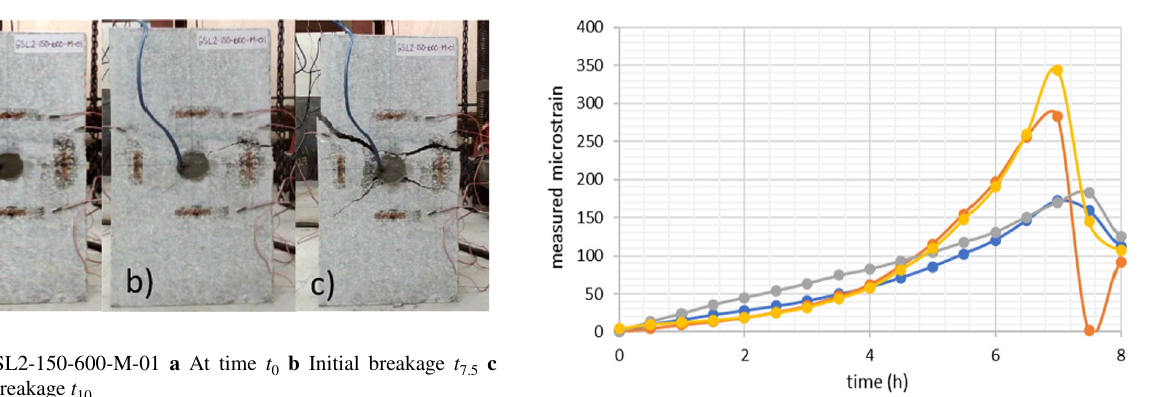
t 0 b Initial breakage 7.5 c Fig. 15 Measured strains of specimen G-SL2-150-600-M-01